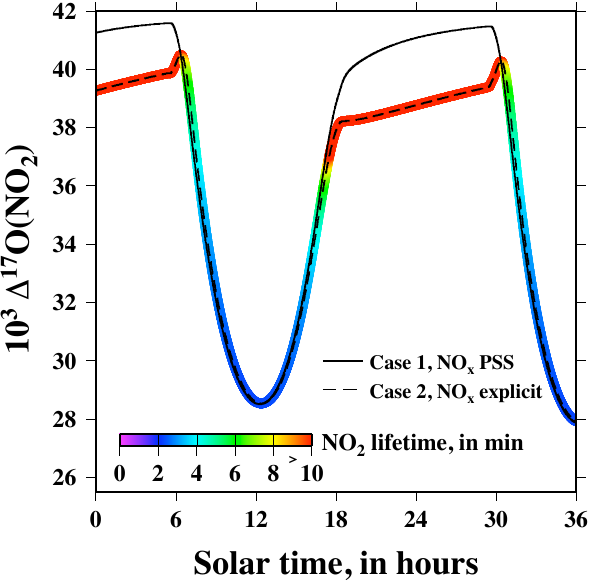
Fig. 5. Diurnal variation of 1 17 O ( NO 2 ) calculated using two different approaches, i.e. permanent photochemical steady-state for NO x (Case 1, solid line) and the explicit computation of 1 17 O ( NO x ) (Case 2, dashed line). The dashed line representing the results of the simulations under Case 2 is overlaid with a color code exhibiting the diurnal variation of the photolytical lifetime of NO 2 . All values above 10 min are shown in red (at night, the pho- tochemical lifetime of NO 2 is virtually infinite).